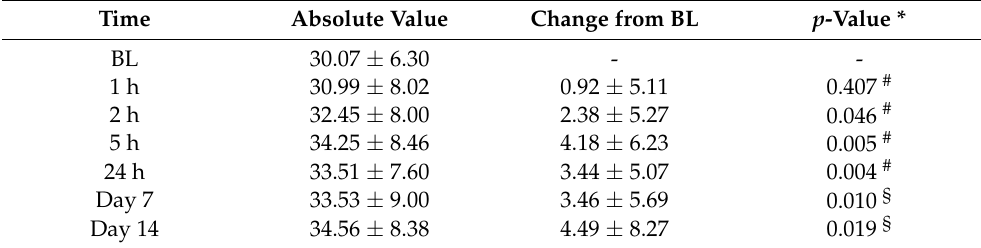
Table 2. Absolute skin capacitance measurement values (forearm, area A1) and changes from baseline after a single application of the face wash gel (first 24 h) followed by twice-daily applications for 13 days.